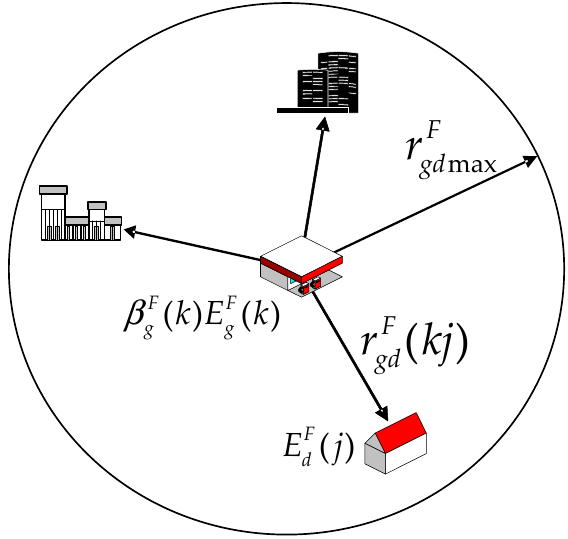
Figure 5. The transfer of FEEQ from gas stations to DCIs in different areas.